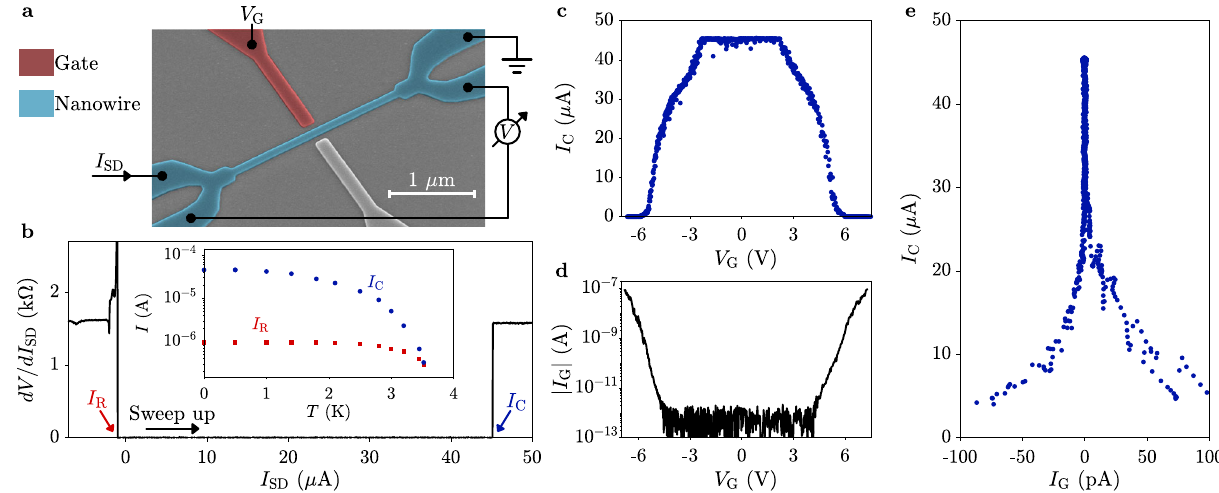
Fig. 1 Operation of a metallic nanowire superconducting switch. a False-color scanning electron micrograph of a device identical to that under study, together with a schematic of the measurement setup. The silicon substrate is gray, the TiN nanowire blue and the gate electrode red. Another gate electrode (gray) was left grouded. b Differential resistance dV / dI SD of the nanowire as a function of I SD , measured by sweeping up I SD starting from − 50 μ A. Critical current I I I I I C and retrapping current R are indicated. Inset: temperature dependence of C (blue dots) and R (red squares). c Critical current C in the nanowire as a function of gate voltage V G . d Absolute value of the gate current I G fl owing between gate and nanowire as a function of V G . A linear component I G ~ 1 T Ω , attributed to leakage in the measurement setup, was subtracted from the data (see Supplementary Note 1). e Parametric plot of I C vs. I G . Obtained from the data in c and d